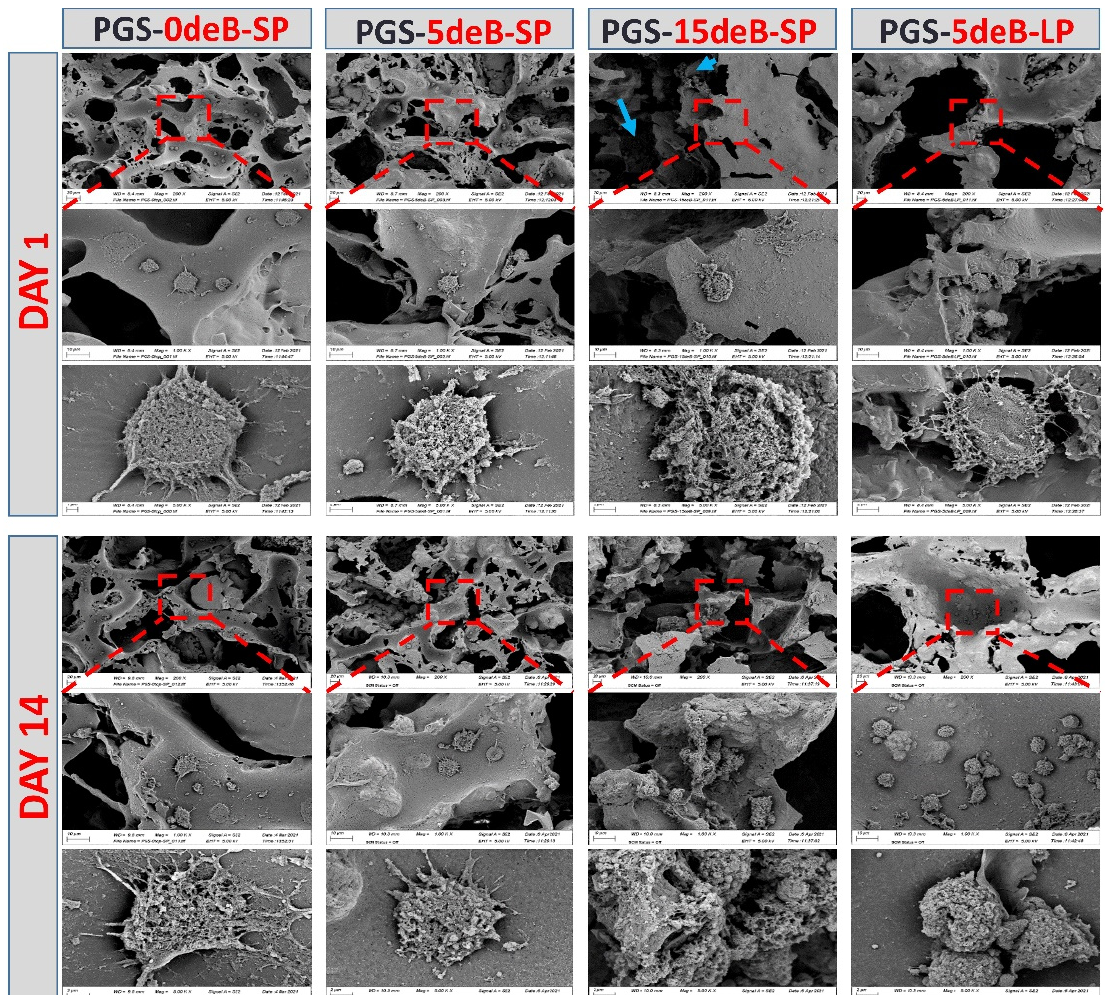
Figure 11. SEM micrographs of the cell-seeded constructs on days 1 and 14 at different magnifications. Red dotted boxes indicate the regions of interest (ROIs) and blue arrows show cells located in a certain depth of PGS-15de-SP scaffolds at DAY 1.